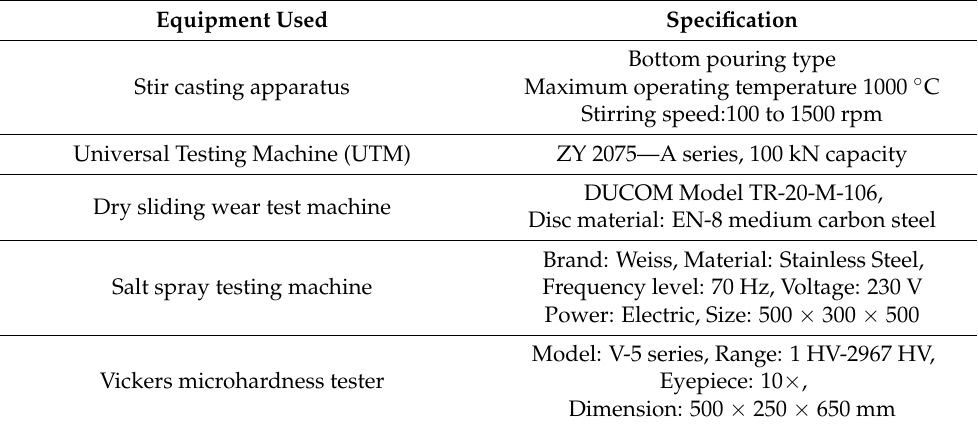
Table 4. Equipment used for testing and